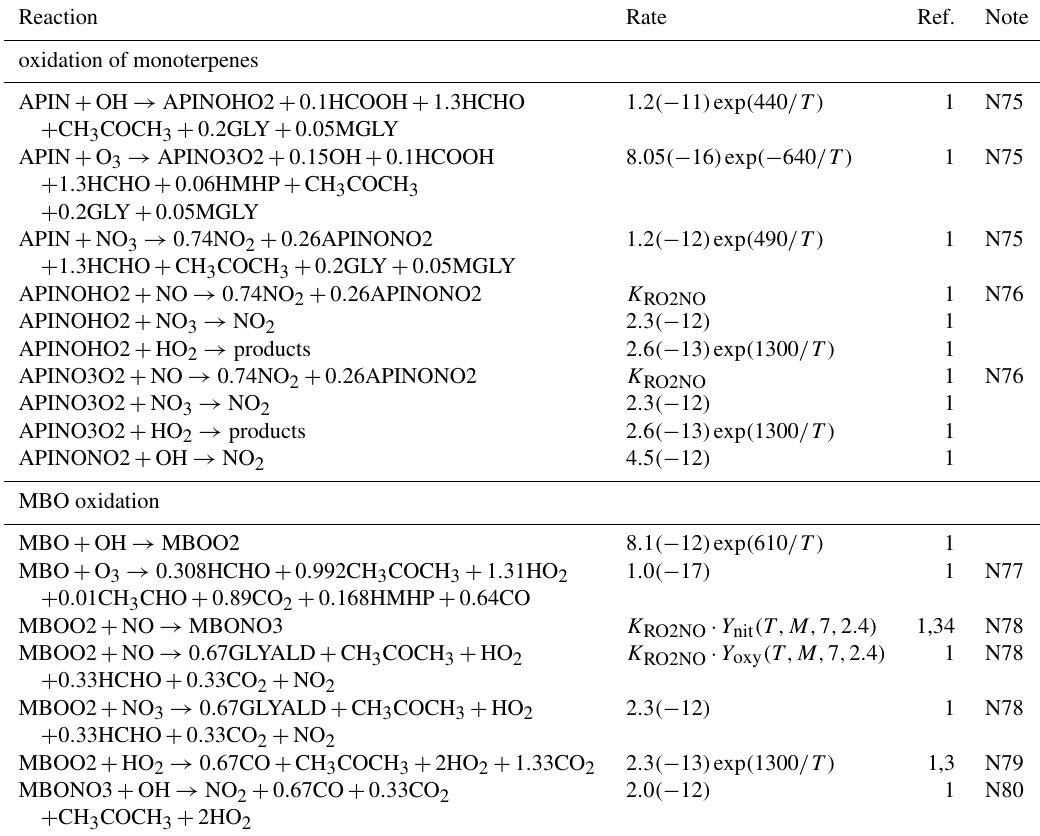
Reaction Rate Ref.